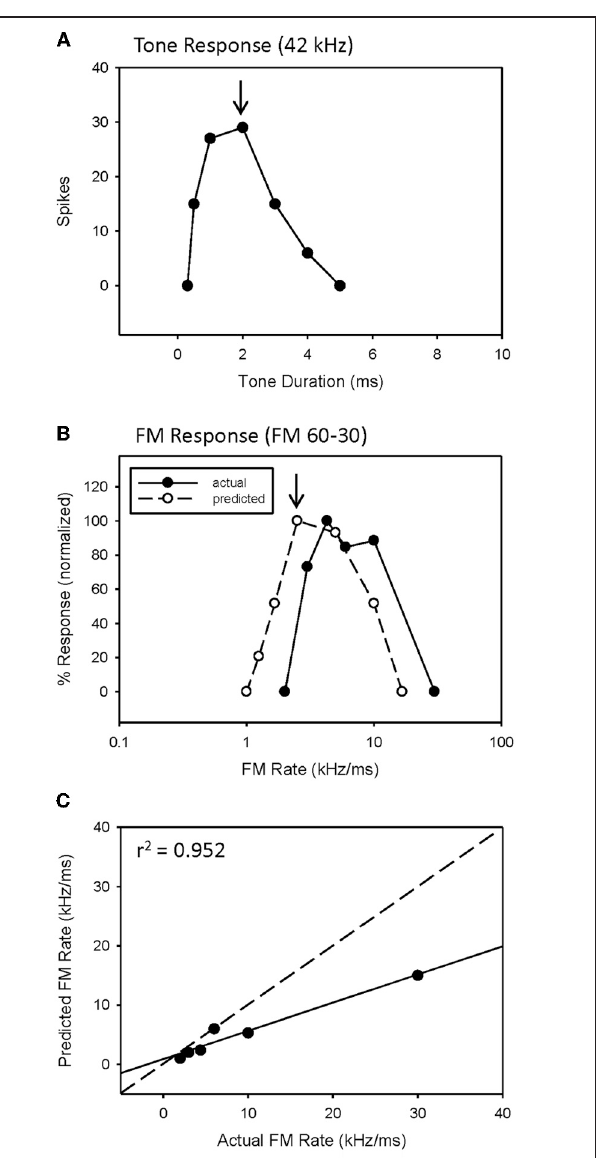
FIGURE 2 | A slowpass FM rate selective neuron (B) exhibiting longpass duration tuning for tones (A). The duration function, based on longpass duration tuning (see Methods), predicted the slowpass FM rate response (B) with a significant correlation between predicted and actual FM rates (C) . The dashed line indicates perfect predictions, and the solid line indicates the actual correlation.